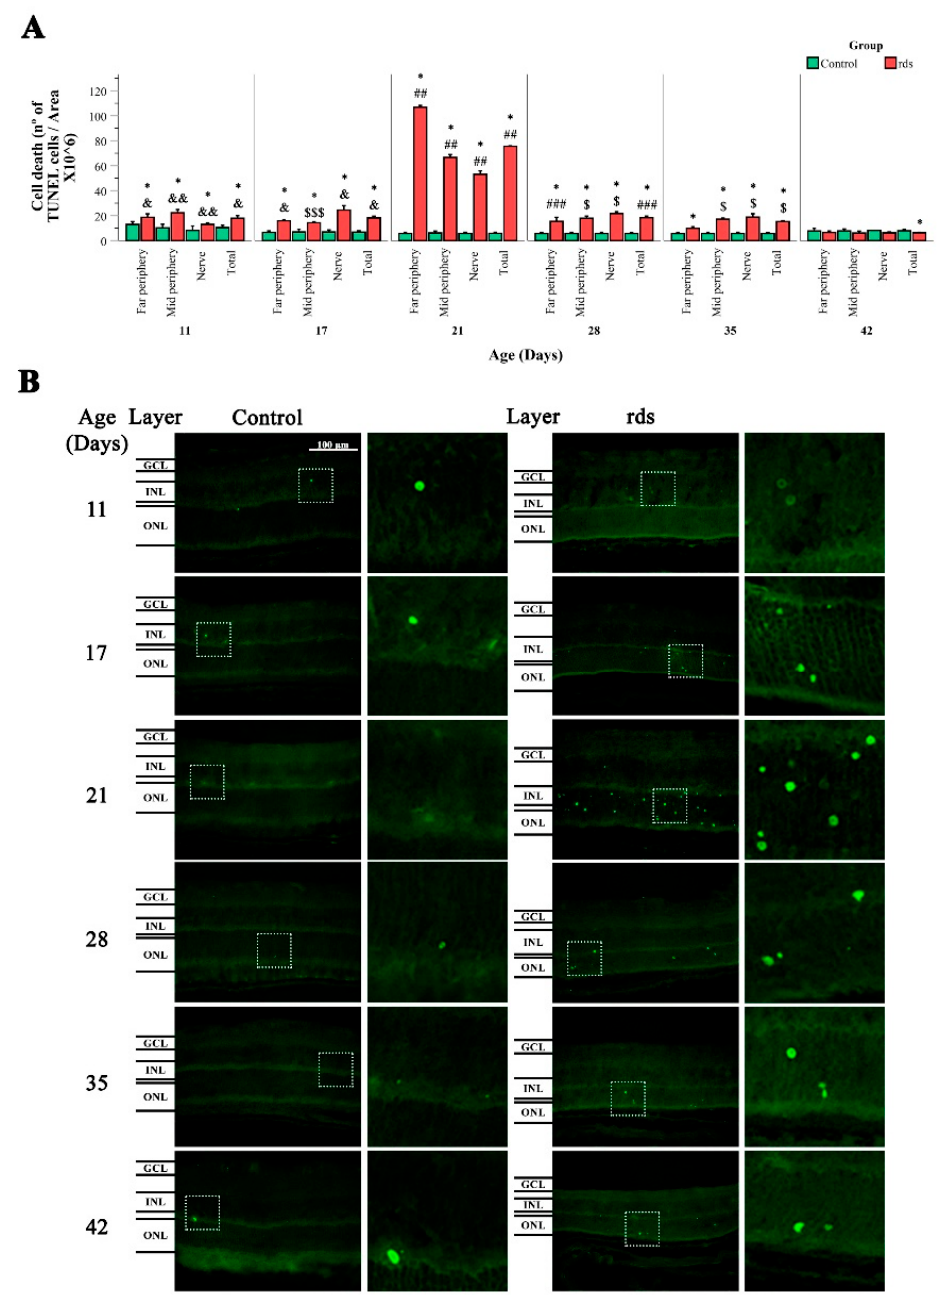
Figure 2. Retinal cell death in control and rds mice. ( A ) TUNEL-positive cells (positive cells × 10 6 /area) at PN11, PN17, PN21, PN28, PN35, and PN42 in the retinas of the control and rds mice in the far periphery, midperiphery, and nerve area. The bars symbolize the means of the number of